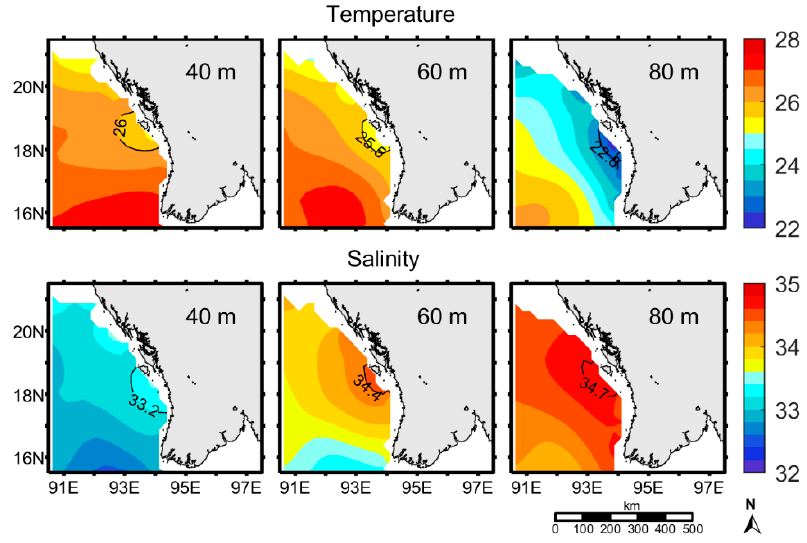
Figure 5. The climatological distributions of temperature (upper panels, unit: °C ) and salinity (lower panels, unit: psu) in the 40, 60 and 80 m layers in the waters of Myanmar in February. Temperature and salinity are from climatological monthly data of WOA18.